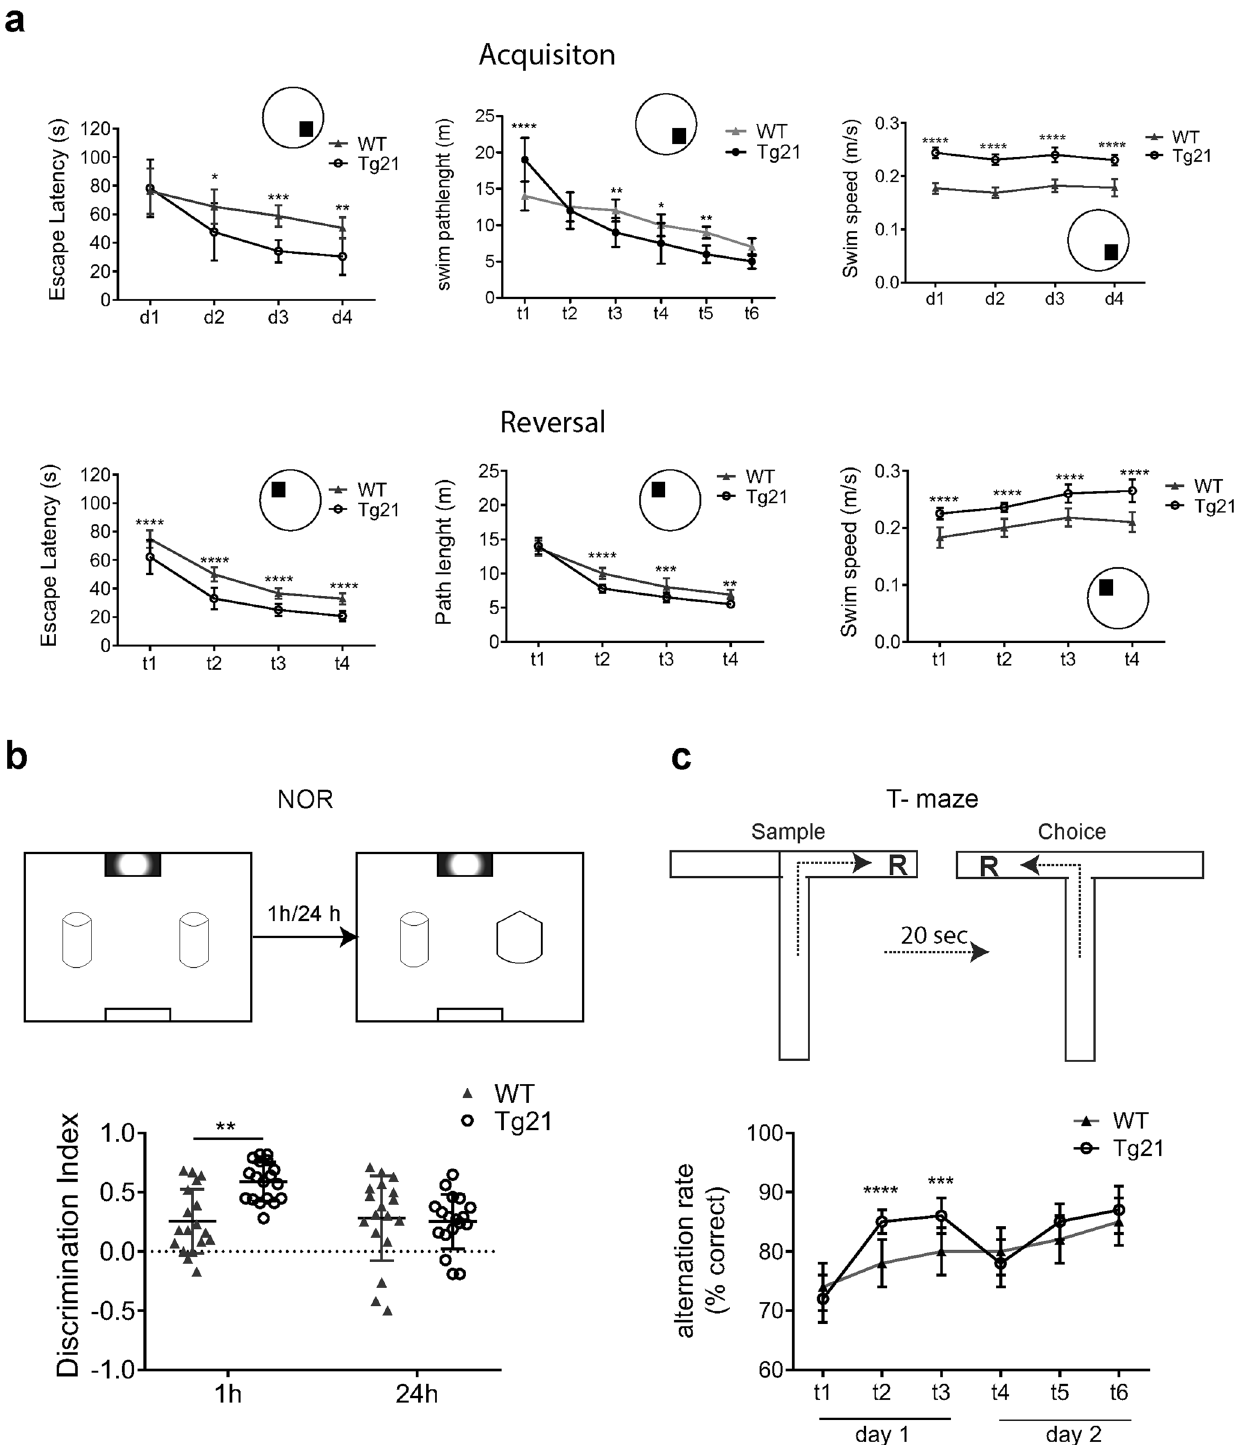
PGC-1 α 51 . However, Erk1/2 generally promotes mitochondrial fi ssion via DRP1 phosphorylation of S616 and suppressing MFN1 under pro-apoptotic conditions 52 . Alternatively, AKT promotes a hyperfused mito- chondrial network by suppressing DRP1 with reciprocal phos- phorylation of DRP1 at S637 and reducing phosphorylation